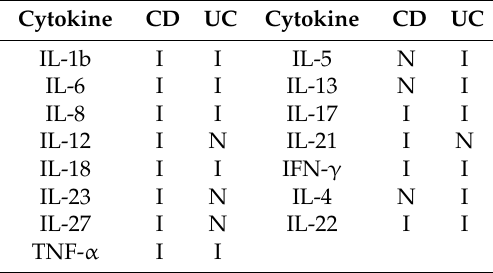
Table 1. Cytokine’s profile in Crohn’s disease (CD) and ulcerative colitis (UC). IL: Interleukin, TNF: Tumour Necrosis Factor, IFN: Interferon, I: Increased, N: Normal. Information based on: